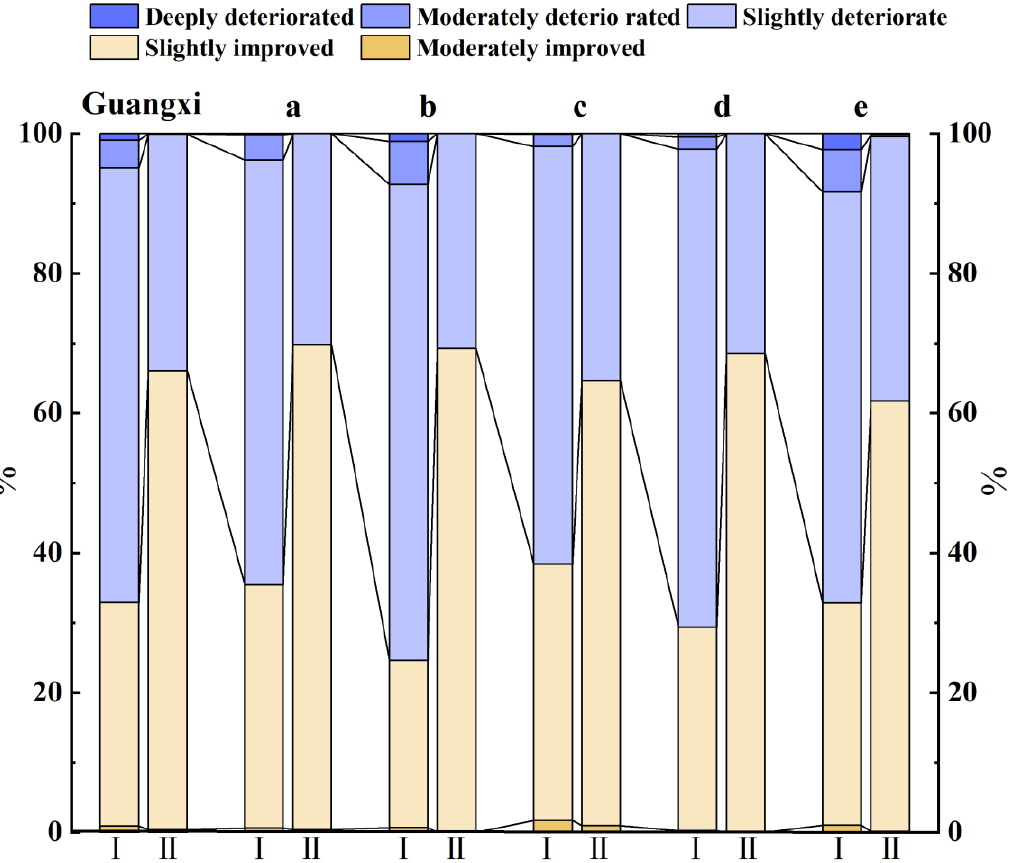
Figure 10. Percentage of ecological-economic value change types in Guangxi and each consolidation area. (Note: ( a ) is the middle karst basin area of Guangxi, ( b ) is the southeast plain area of Guangxi, ( c ) is the northeast hilly mountain area of Guangxi, ( d ) is the northwest mountain area of Guangxi, ( e ) is the coastal hilly plain area.)